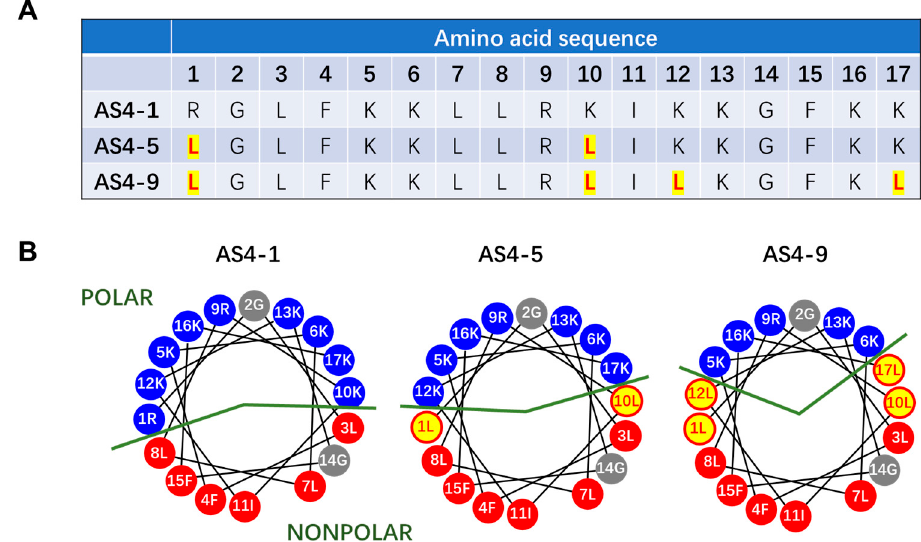
Figure 1. Amino acid sequences ( A ) and helical wheel representation ( B ) of the three types of peptides, i.e., AS4-1, AS4-5, and AS4-9. The mutated residues are emphasized in red with a yellow background. In ( B ), hydrophilic amino acids are shown with a blue background, and hydrophobic amino acids are shown with red and gray backgrounds. Green lines represent the interface between polar and nonpolar sides.